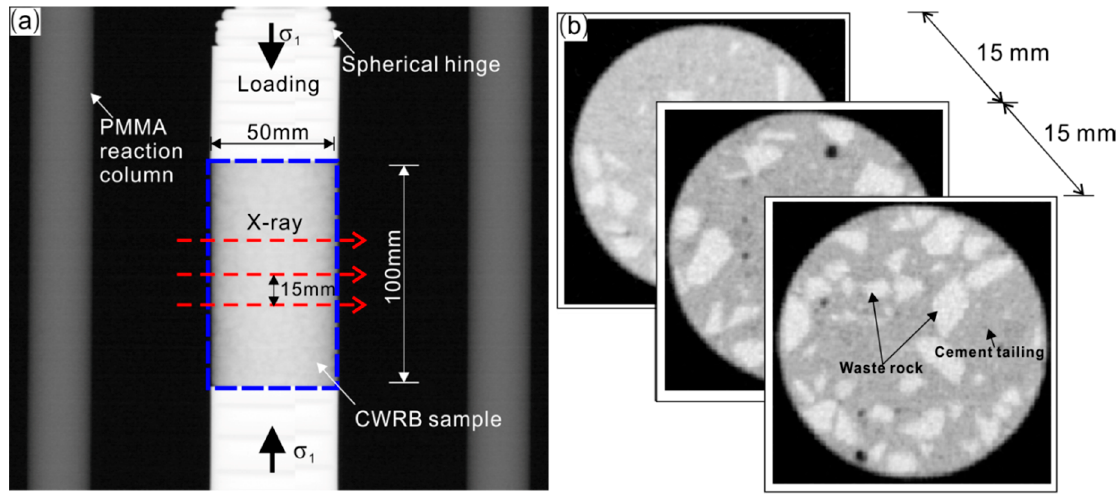
Figure 8. Scheme of X-ray CT scanning of the CWRB sample. ( a ) Perspective of the scanning position, the initial scanning position was35mm, 50mm, and 65mm; ( b ) Reconstructed CT images before loading.